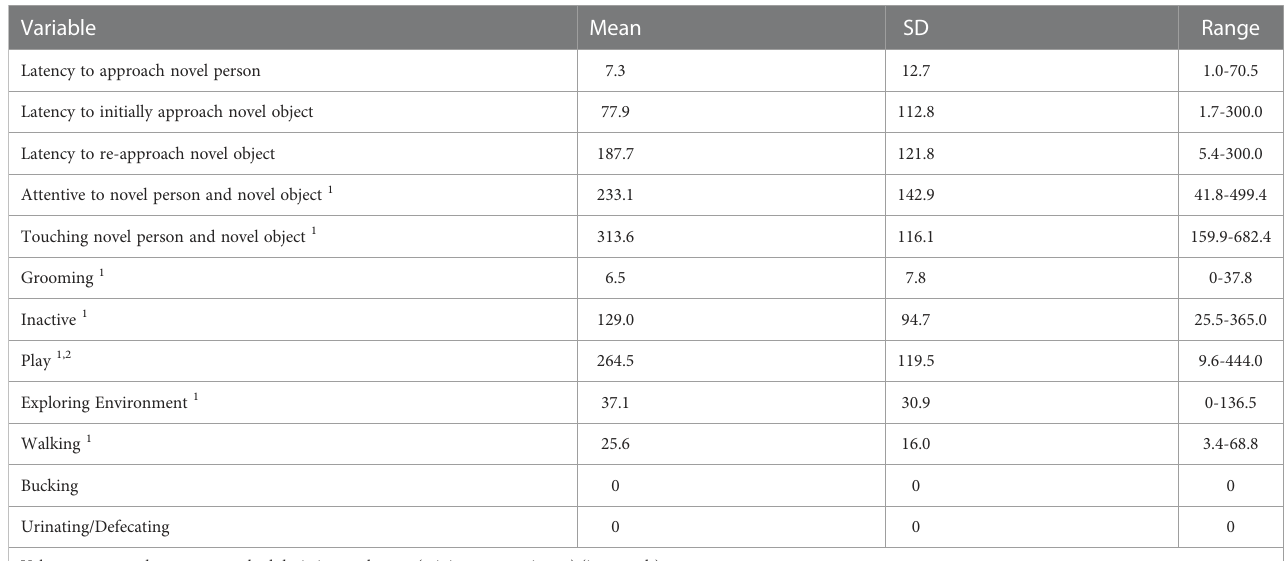
TABLE 2 Behavioral responses of Holstein x Angus crossbred calves (n=29) during the standardized personality tests (novel person and novel object/ startle tests) when tested individually in their home pen at 81.6 ± 2 d old.